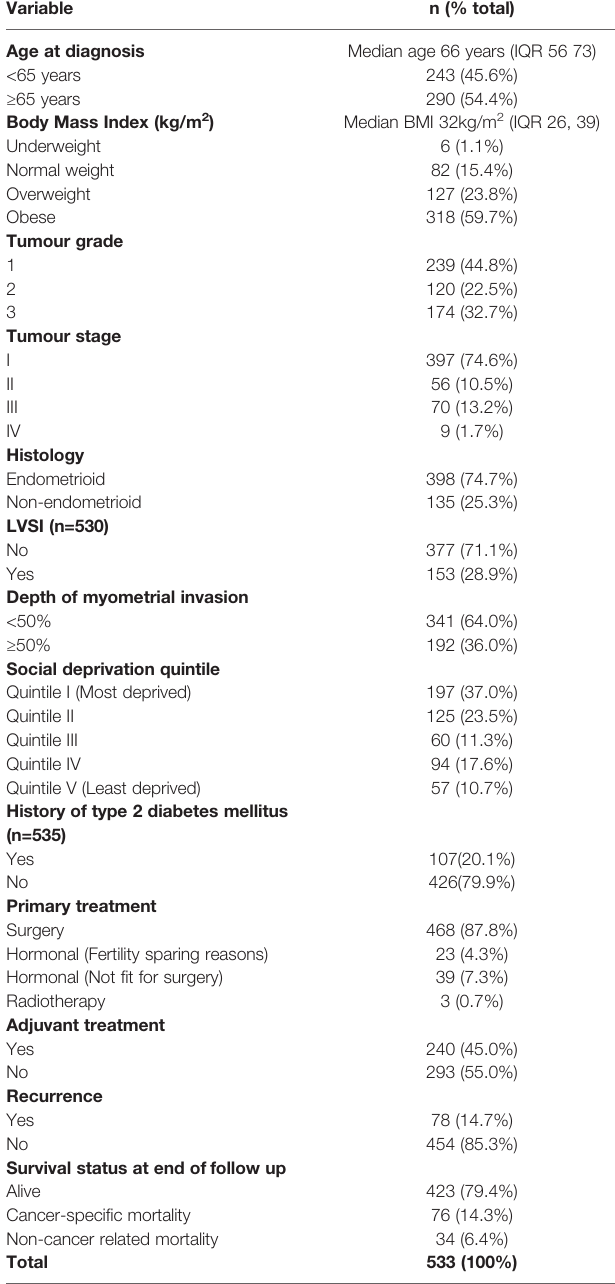
TABLE 1 | Socio-demographic characteristics of the study